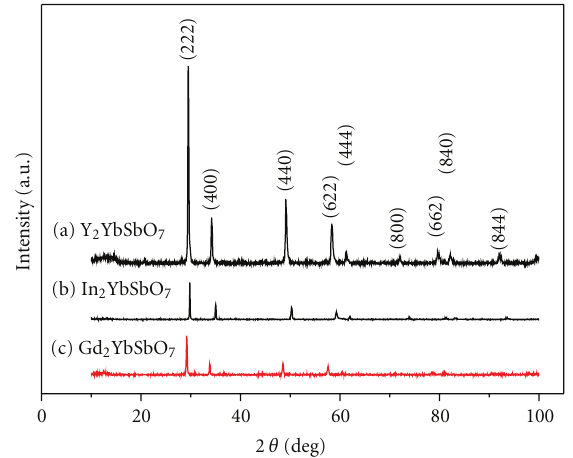
Figure 1: X-ray powder di ff raction patterns of In 2 YbSbO 7 , Gd 2 YbSbO 7 , or Y 2 YbSbO 7 prepared by a solid-state reaction method at 1320 ◦ C.